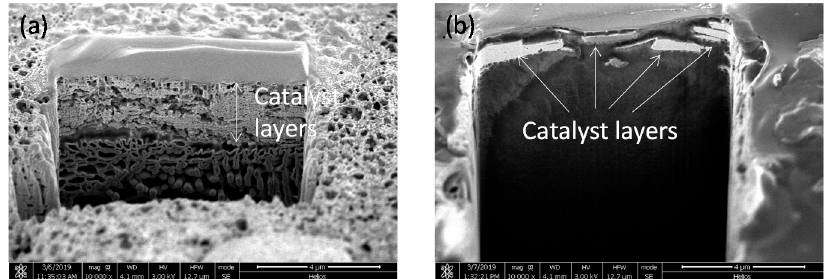
Figure 6. Cross section SEM images of ( a ) porous Pt and ( b ) Pt black layers.